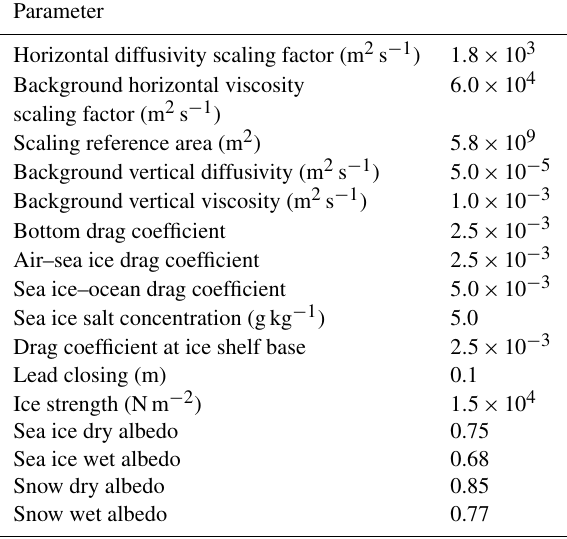
Table 1. Model parameters used for the simulations in this study. Horizontal diffusivity and viscosity are scaled by area. For example, a grid element with an area of 5 . 8 × 10 9 m 2 or a 1.5 ◦